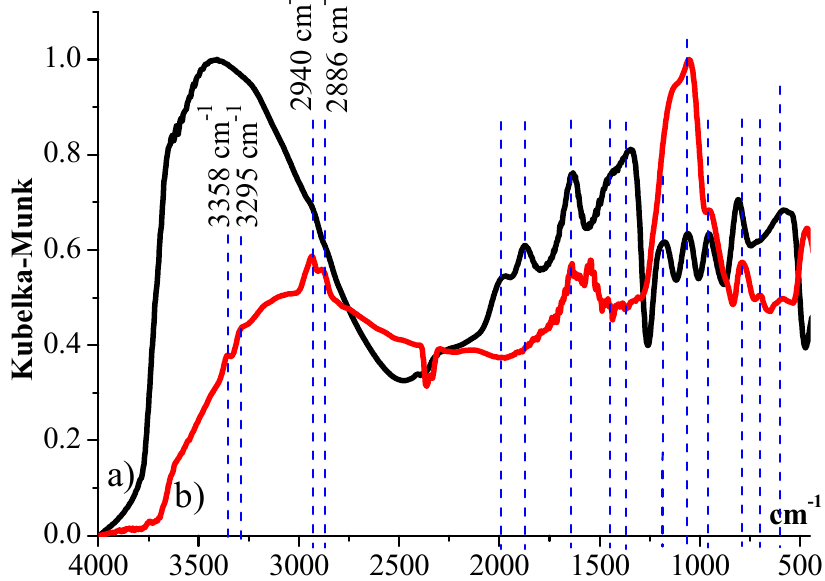
Figure 2. FTIR spectra of supports’ surface: ( a ) SiO 2 ; ( b ) SiO 2 -C 3 H 6 -(30%)NH 2 .